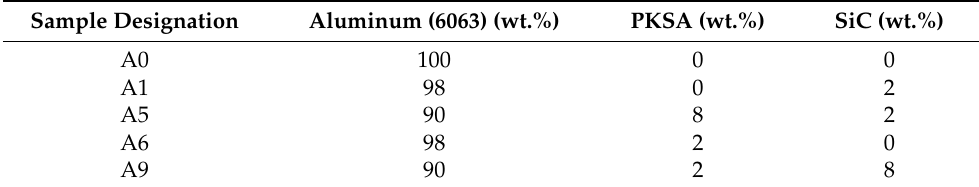
Table 1. Designation of composite samples